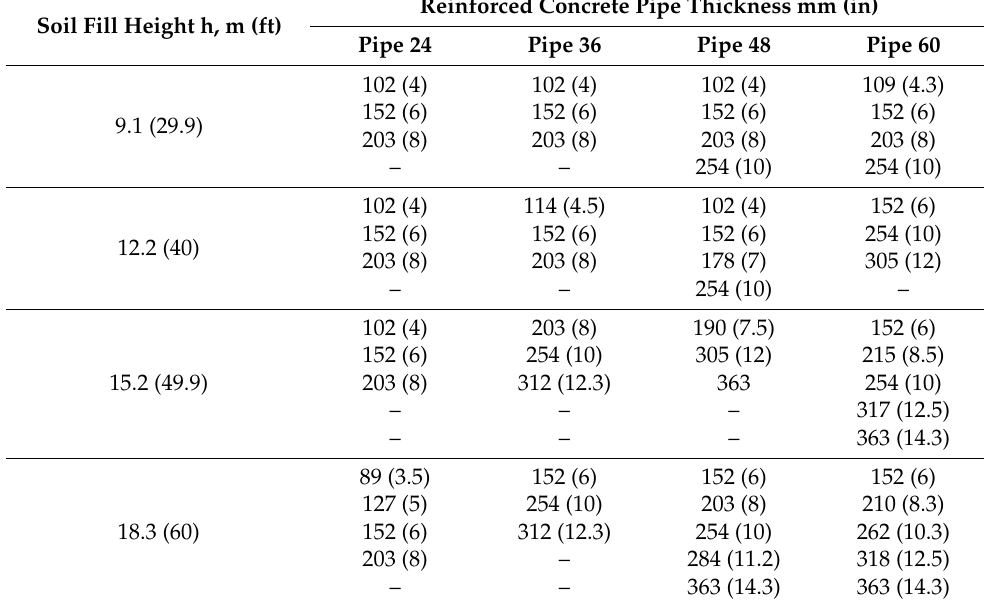
Table 2. Thickness and soil fill depth of the analyzed reinforced concrete pipes.